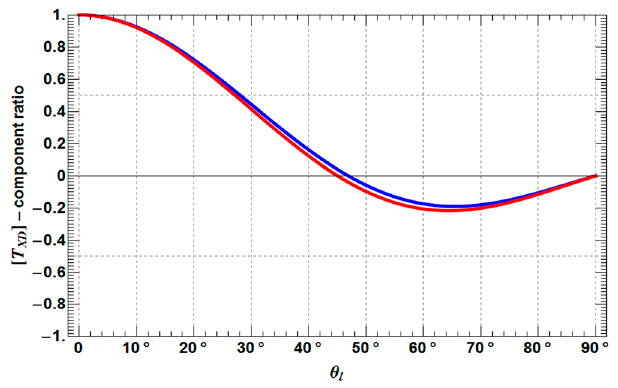
Figure 20. Sensitivity of ( T XD22 − T XD33 )/( T XD22 + T XD33 ) with roughness angle θ 1 (blue) ( ε s = 20, ε t = 10, ω l = 60 ◦ , φ = 0 ◦ ) and comparison with sinc (4 θ 1 ) (red).